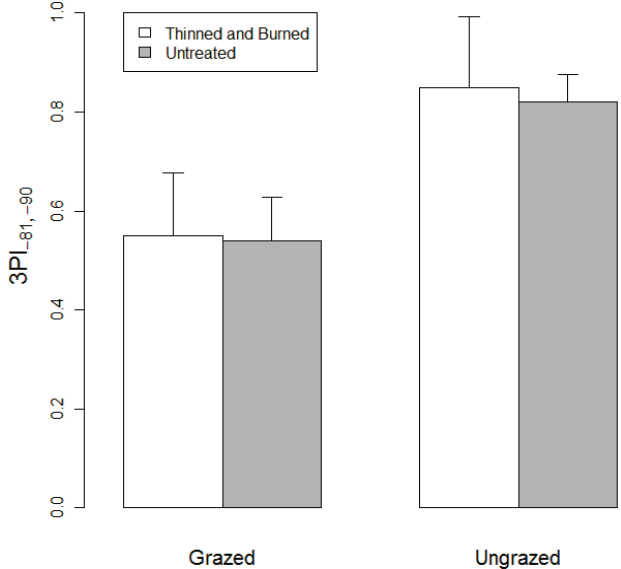
Figure 6. Mean values of the Three-dimensional Vegetation Patchiness Index (3PI) for zenith angles between − 81° and − 90° for grazed and ungrazed plots that were either thinned and burned or untreated. Standard error bars are shown.